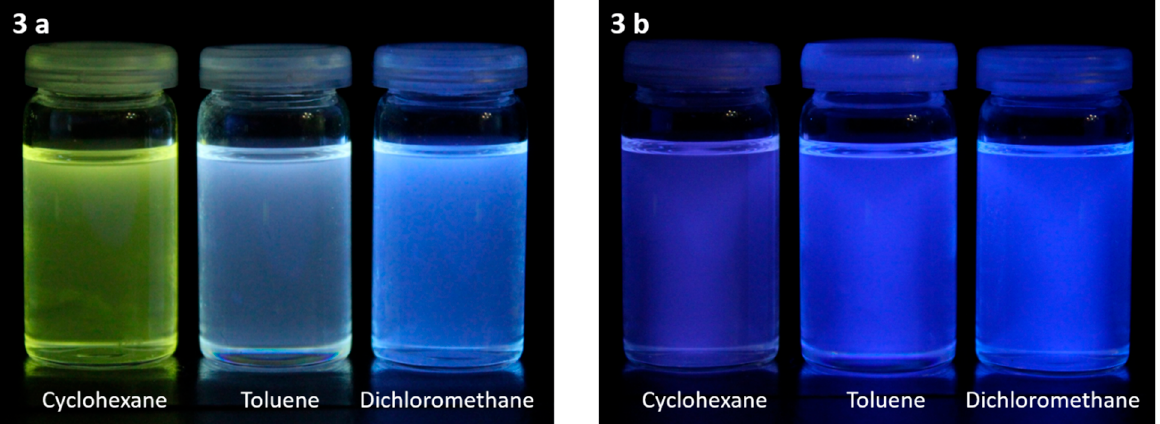
Figure 23. Photographs of solutions of polymers 3 a,b in cyclohexane, toluene and dichloromethane under UV light with a wavelength of 365 nm.